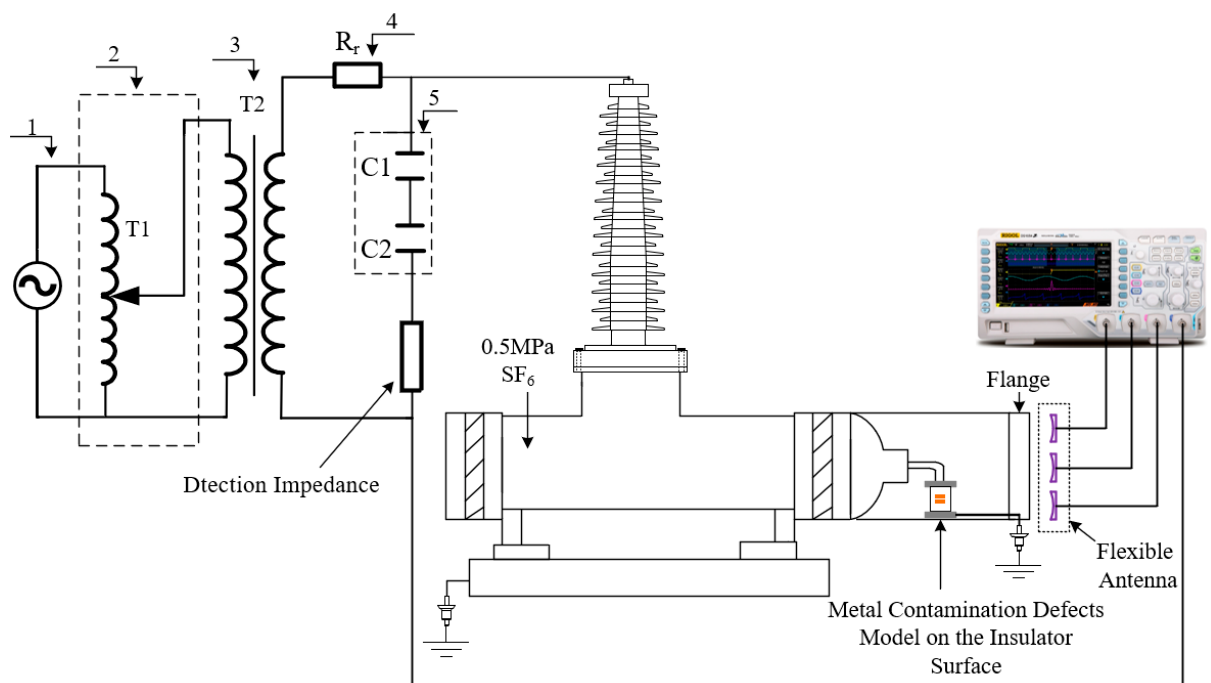
Figure 14. Metal contamination defects model on the insulator surface.